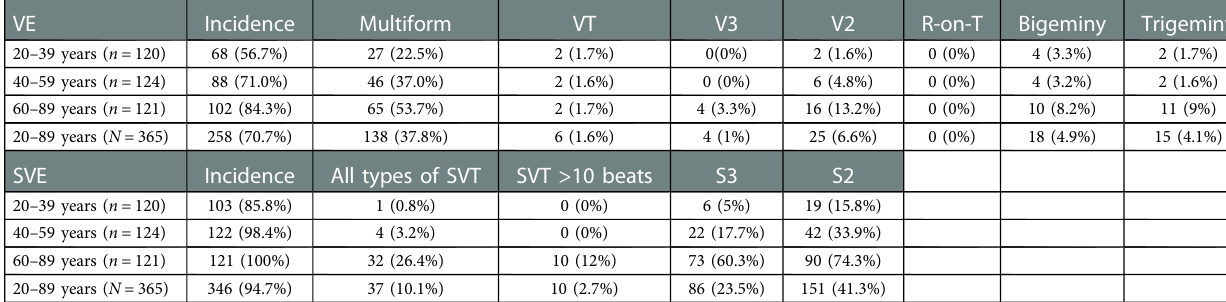
TABLE 4 Complex ectopy and tachycardia on 24-h AECG ( N =365). VE Incidence Multiform VT V3 V2 R-on-T Bigeminy Trigeminy